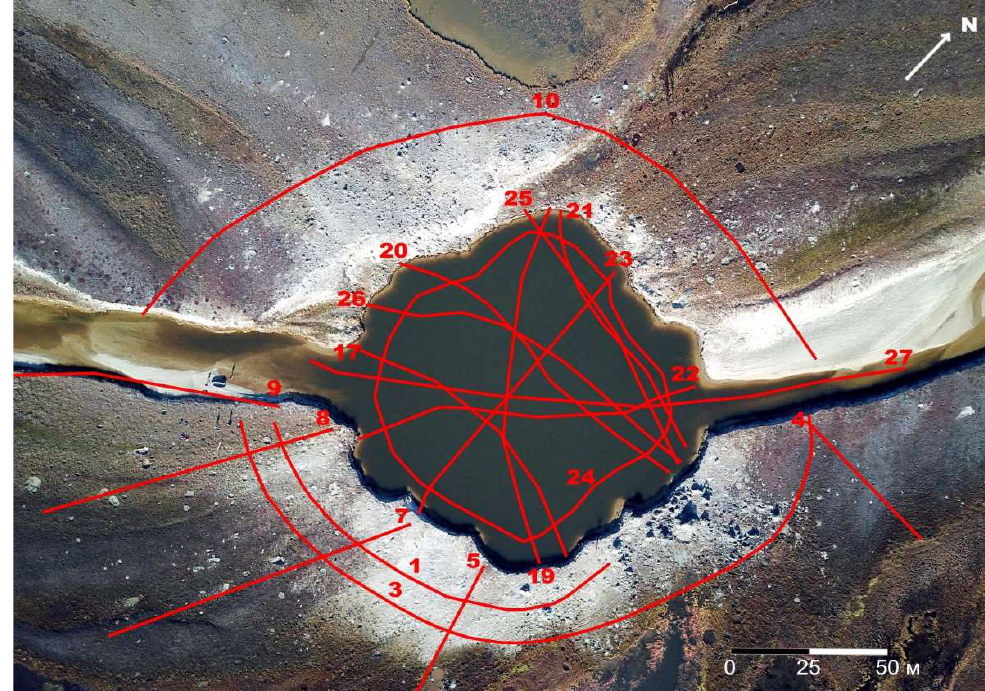
Figure 7. Lines of the GPR survey within the Seyakha C11 Crater and adjacent territory. Basemap: aerial image from the drone, 18 September 2018 (photo by Igor Bogoyavlensky).